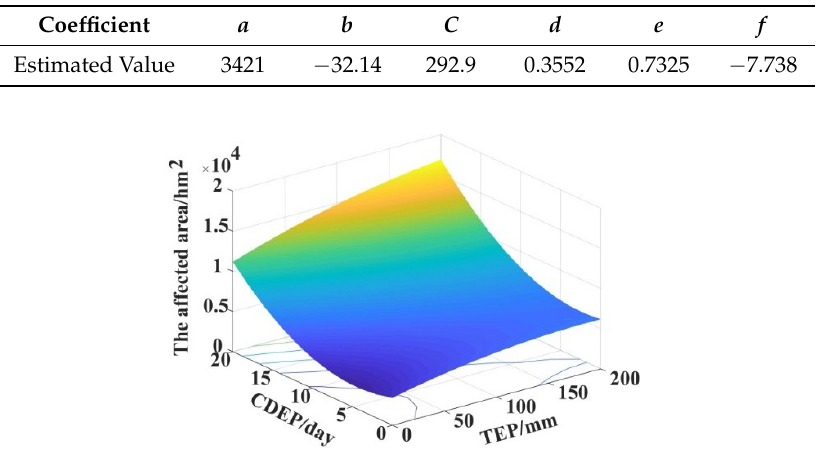
Figure 6. Vulnerability surface of crops in the MJP.